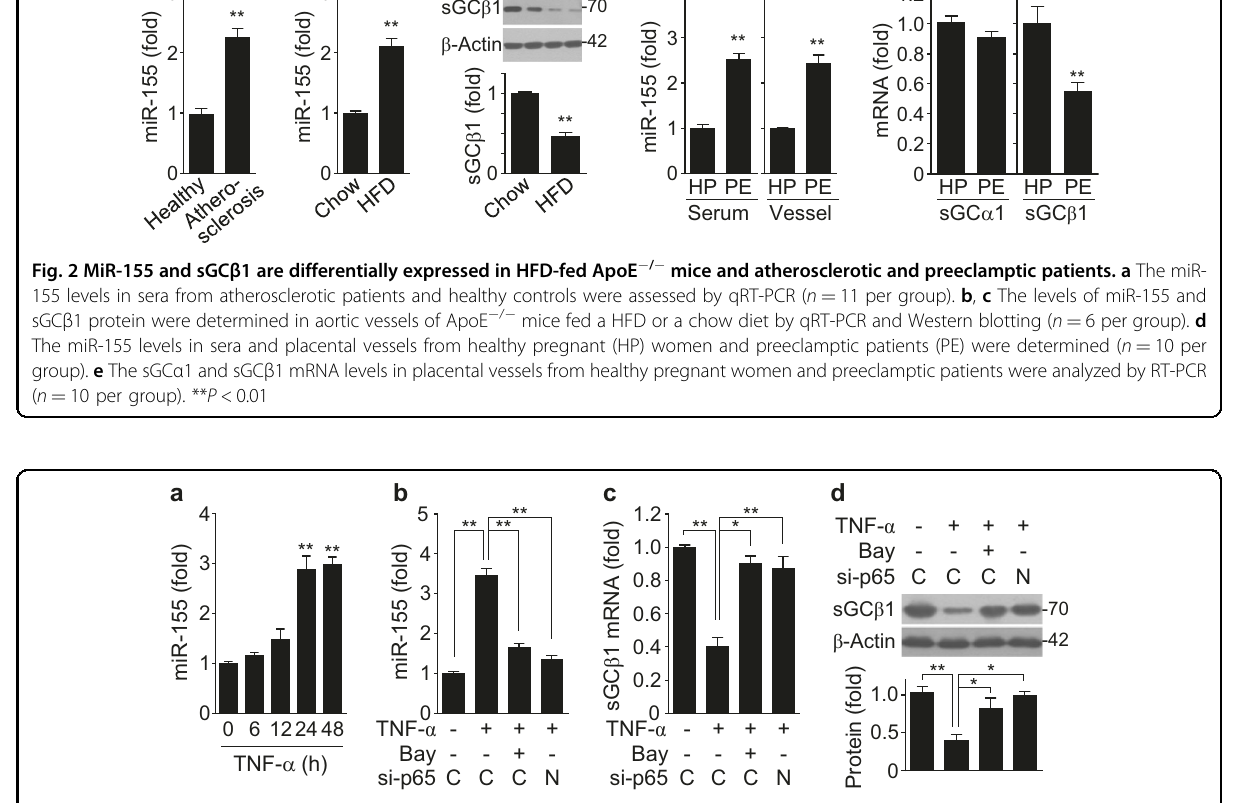
Fig. 3 TNF- α inhibits sGC β 1 expression through the biogenesis of NF- κ B-responsive miR-155. a HASMCs were treated with TNF- α (10 ng/mL), and the miR-155 levels were determined by qRT-PCR ( n = 3). b – d HASMCs were transfected with 80 nM of control (C) or NF- κ B p65 siRNA (N) and treated with or without TNF- α in the presence or absence of Bay11-7082 (Bay, 5 μ M) for 24 h. b , c The miR-155 and sGC β 1 mRNA levels were determined by qRT-PCR ( n = 6). d The sGC β 1 protein levels were determined by Western blotting ( n = 3). * P < 0.05 and ** P < 0.01